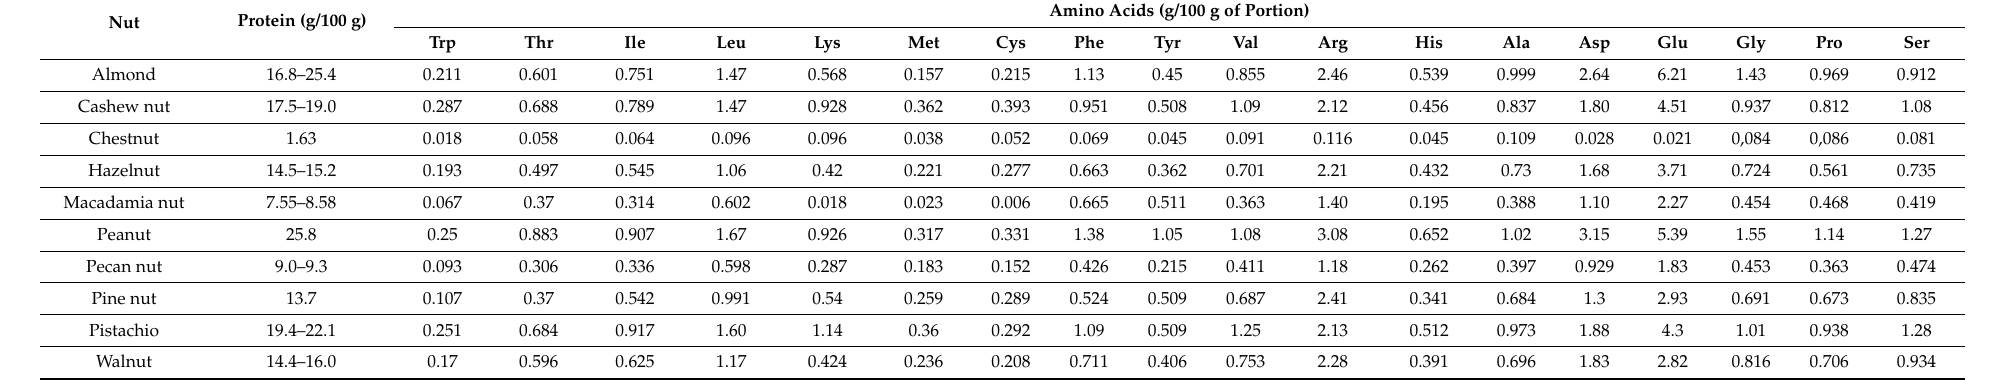
Table 1. Protein and amino acid contents of selected nuts (compiled from